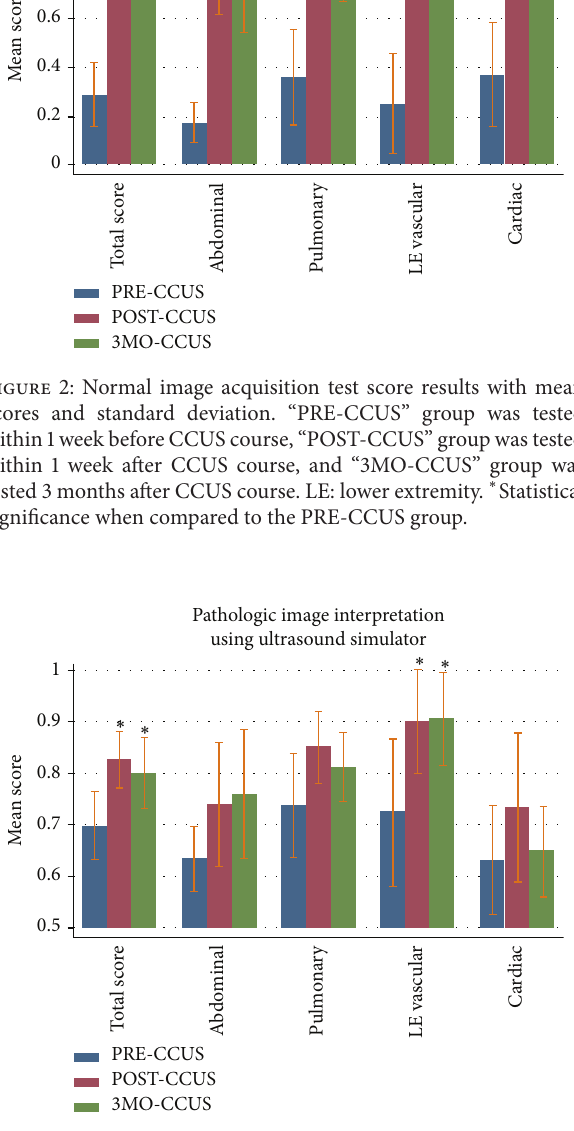
Figure 3: Pathologic image interpretation test score results with mean scores and standard deviation. “PRE-CCUS” group was tested within 1 week before CCUS course, “POST-CCUS” group was tested within 1 week after CCUS course, and “3MO-CCUS” group was tested 3 months after CCUS course. LE: lower extremity. ∗ Statistical significance when compared to the PRE-CCUS